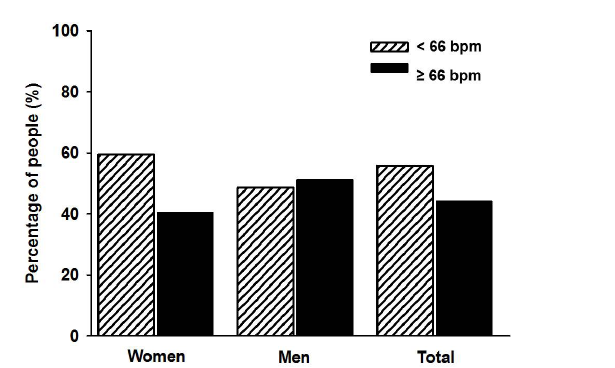
Figure 1. Prevalence of resting heart rate according to gender in elderly aged 80 years and